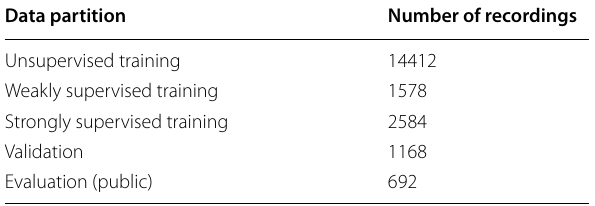
Table 2 Number of samples per partition in data